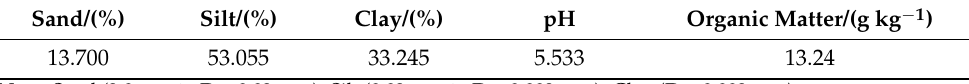
Table 1. Basic physical and chemical properties of soils.